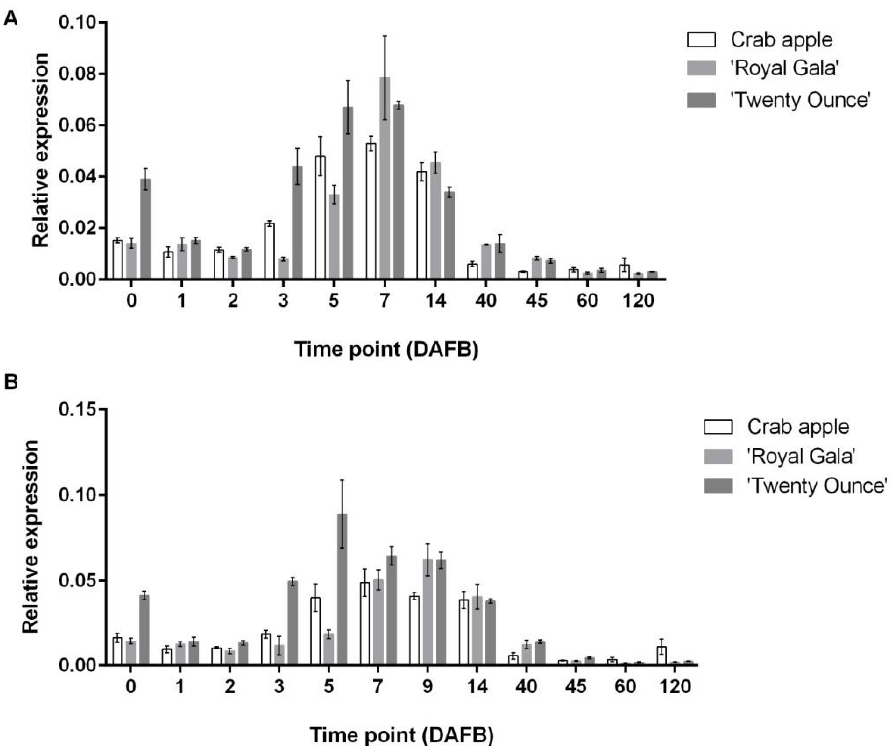
Figure 6. Differential expression of MdCDKB2:2 in three cultivars during Season 2, relative to the control gene, MdGAPDH . ( A ) Relative expression in biological Replicate 1 (Rep1). ( B ) Relative expression in biological Replicate 2 (Rep2). Error bars = standard deviation; n = 3 (technical replicates). Expression levels between time points and cultivars were statistically different, ANOVA (two-factor), p -value ≤ 0.05.